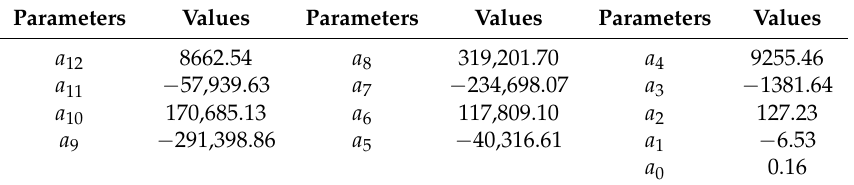
Table A1. Voltage hysteresis state H function parameters and its